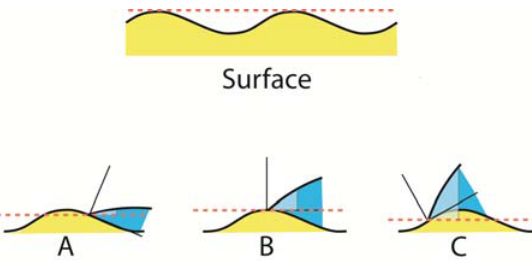
Figure 7. Surfaces are usually not absolutely flat as assumed by Young’s equation. As a drop of water moves uphill ( A ), the contact angle at the liquid edge tends to be under-estimated (light blue color) in relationship to a flat horizontal surface (red dotted line). At the tip of the hill ( B ), the contact angle assumes a value which is equal to an assumed flat surface. As the liquid edge moves downhill ( C ), the contact angle tends to become over-estimated in relationship to the red horizontal line. The light-blue field represents what would be perceived as contact angles at the different locations under the assumption that the surface is